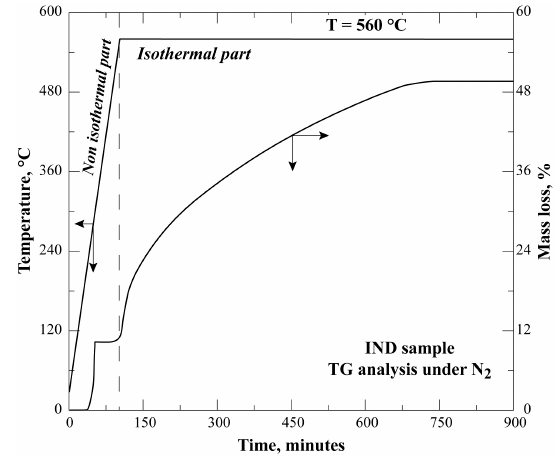
Figure 6. Typical example of TG analysis results of iron sulfate decomposition.